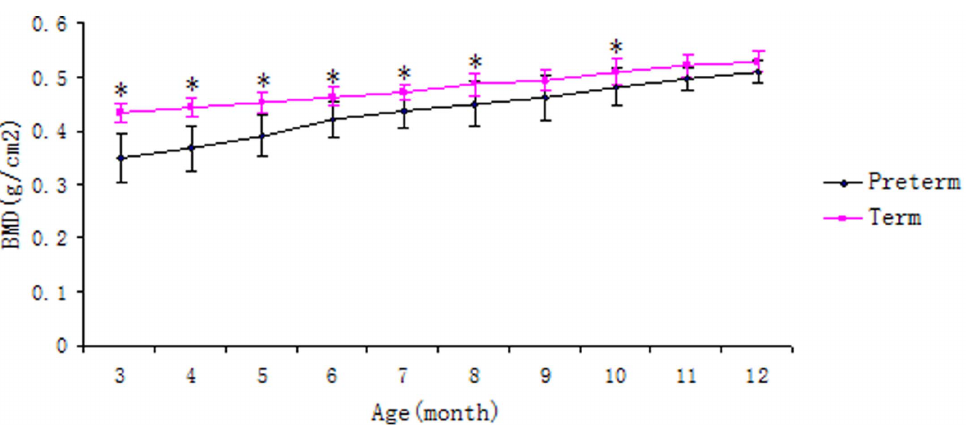
Figure 1. The development of BMD of term and gestational age-adjusted preterm infants aged 3 , 12 months (*p , 0.05, compared with the preterm of the same age after adjusting for the gestation).